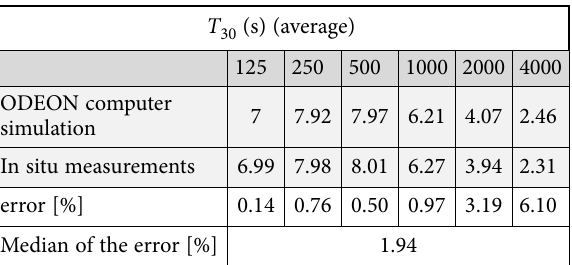
Table 5. Comparison of results of T for simulations and in situ measurements